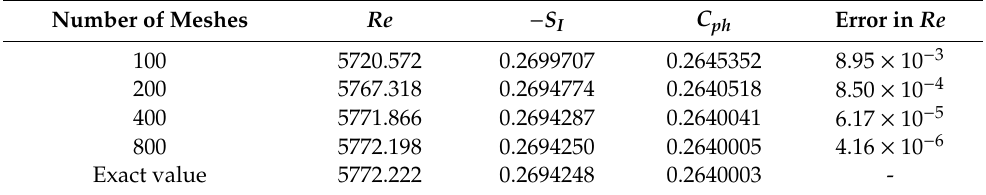
Table 1. Dependency on number of meshes for the neutral value of Reynolds number, angular frequency, phase speed, and relative error in Reynolds number deviated from the exact value at α = 1.0205474 and S R = 0.